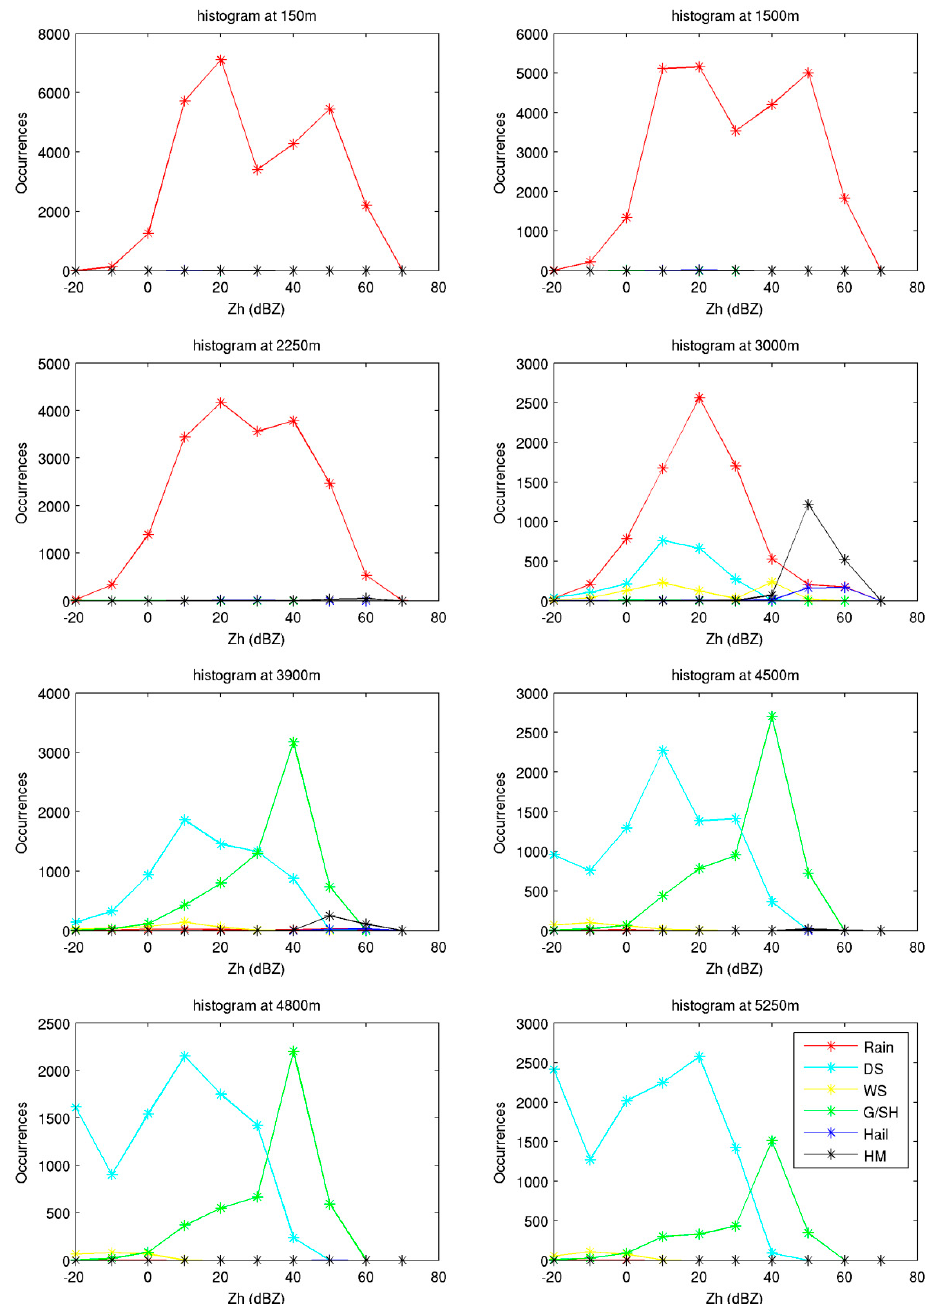
Figure A1. Histograms of Z h for samples of the WRF scenario at different heights for the six hydrometeors classified using the WRF mixing ratio, as shown in Table 1. In the legend, DS, WS, G/SH, and HM mean dry snow , wet snow , graupel/small hail , and hail mix , respectively.